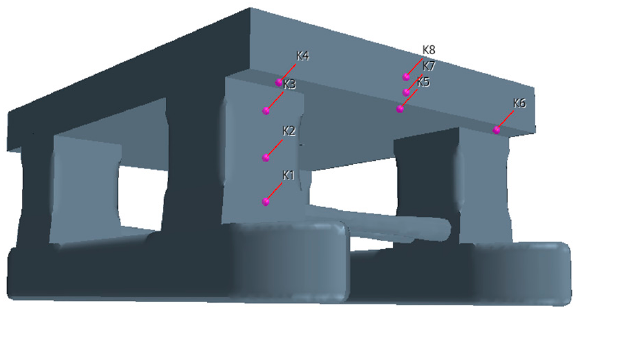
Figure 11. ( a ) Location of the slam-pressure monitoring points K1 to K8. ( b ) Location of the slam- pressure monitoring points A1 to A22, L1 to L9, C1 to C9 and R1 to R9.